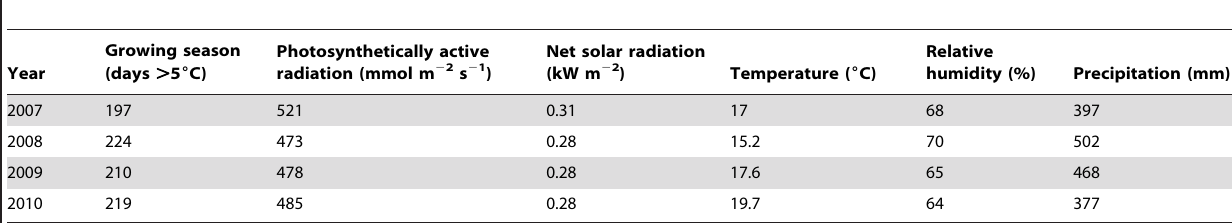
Table 1. Weather conditions expressed as daily averages in the study area during the growing seasons (May–October) of the study period